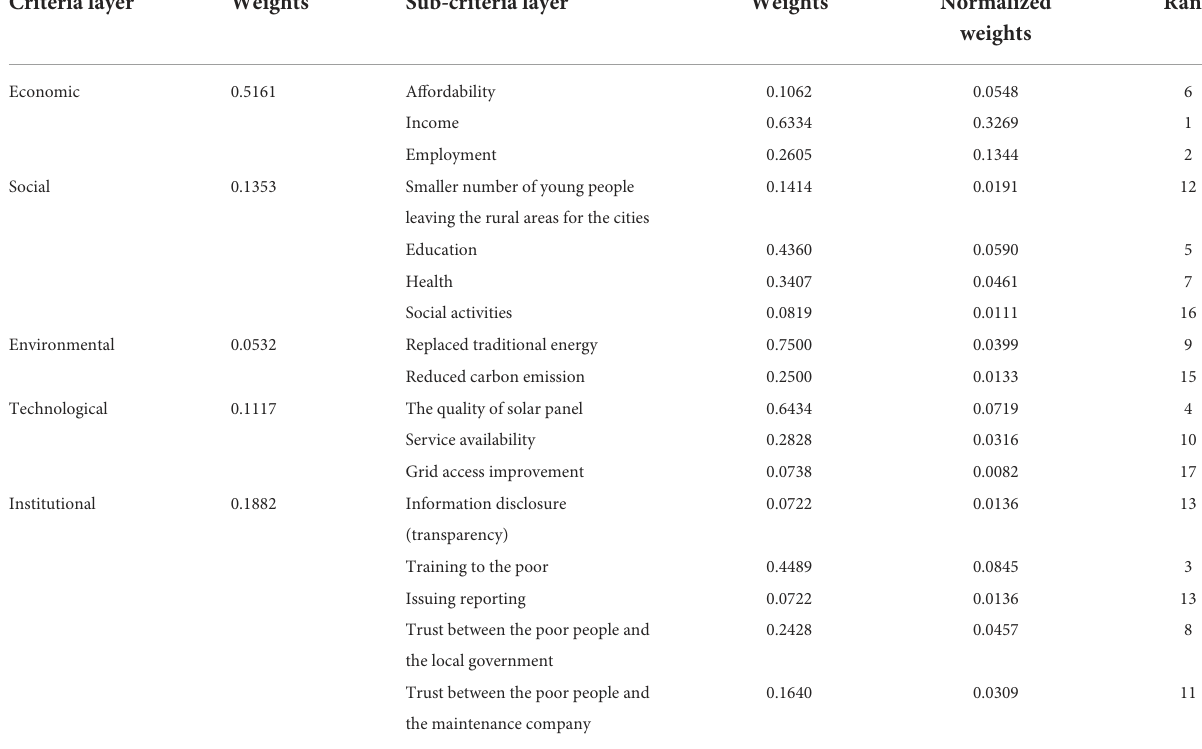
TABLE 6 Weighting factor of sustainability framework